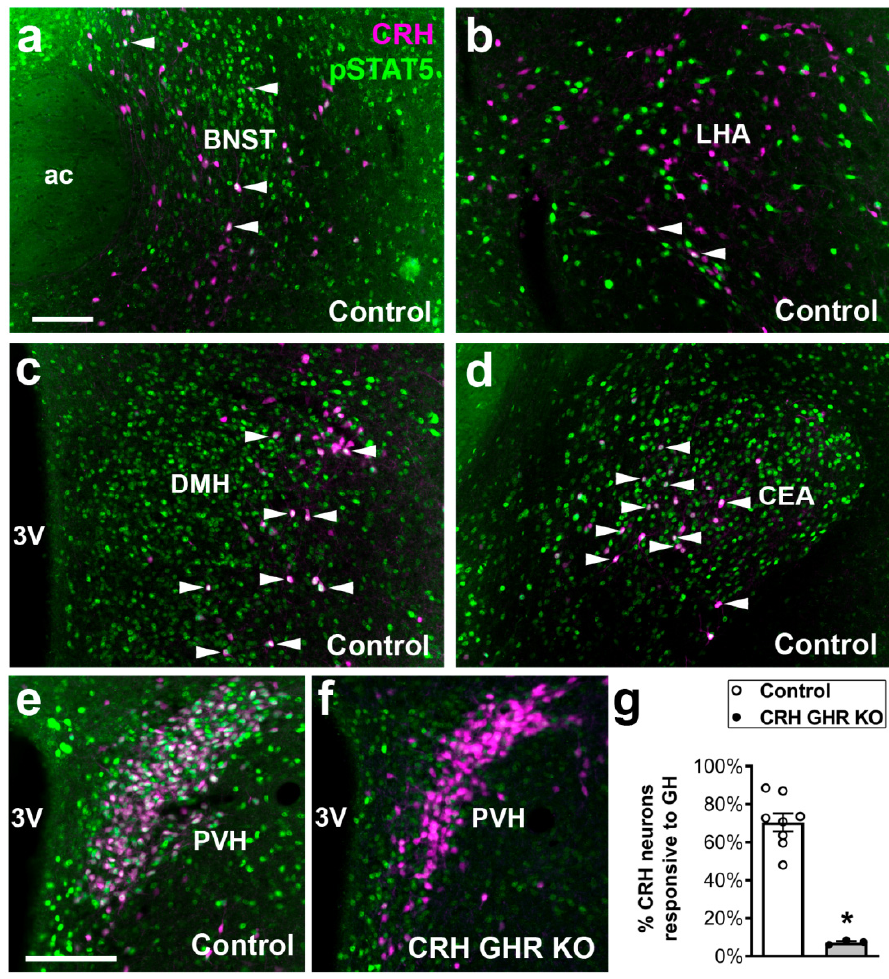
Figure 1. Distribution of CRH neurons that are responsive to GH. ( a – e ) Epifluorescence photomicrographs illustrating the co-localization between pSTAT5 (green nuclear staining) and CRH (magenta cytoplasmic marking) in GH-injected control mice. Arrowheads indicate examples of double-labeled neurons (appear as white). ( f ) Significant reduction of co-localizations between pSTAT5 and CRH in GH-injected CRH GHR KO mice. ( g ) Quantification of the percentage of PVH CRH neurons that are responsive to GH in control ( n = 8) and CRH GHR KO mice ( n = 3). * p < 0.0001. Abbreviations: 3V, third ventricle; ac, anterior commissure. Scale bars: ( a ) = 100 µ m; ( e ) = 50 µ